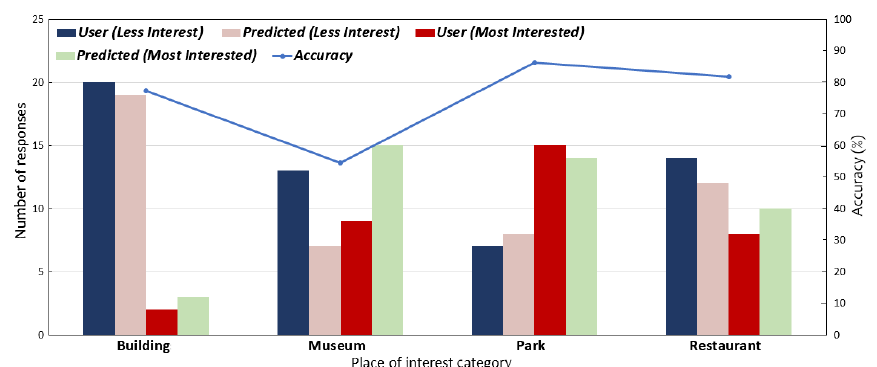
Fig. 6 Confusion matrix for recency effect model: User response vs. prediction